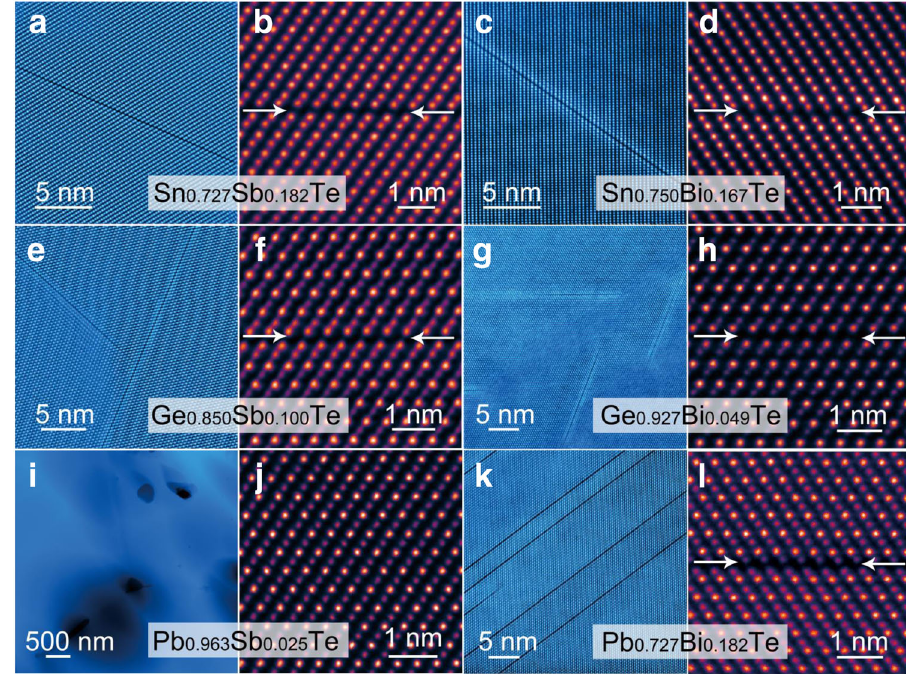
Fig. 6 | The library of QG-like structure in IVA-VIA compounds. The low mag- ni fi cation and high magni fi cation images of Sn 0.727 Sb 0.182 Te ( a , b ) ( 51 );